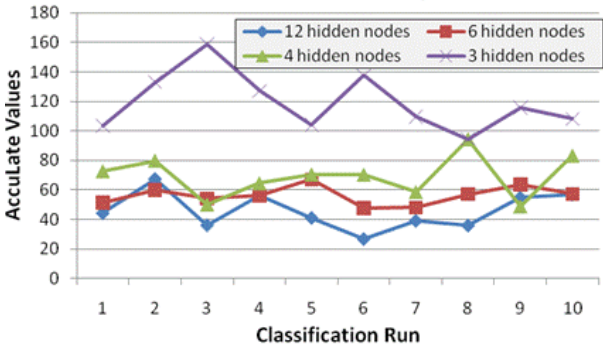
Fig. 9: ANN AccuLate Values for Unknown